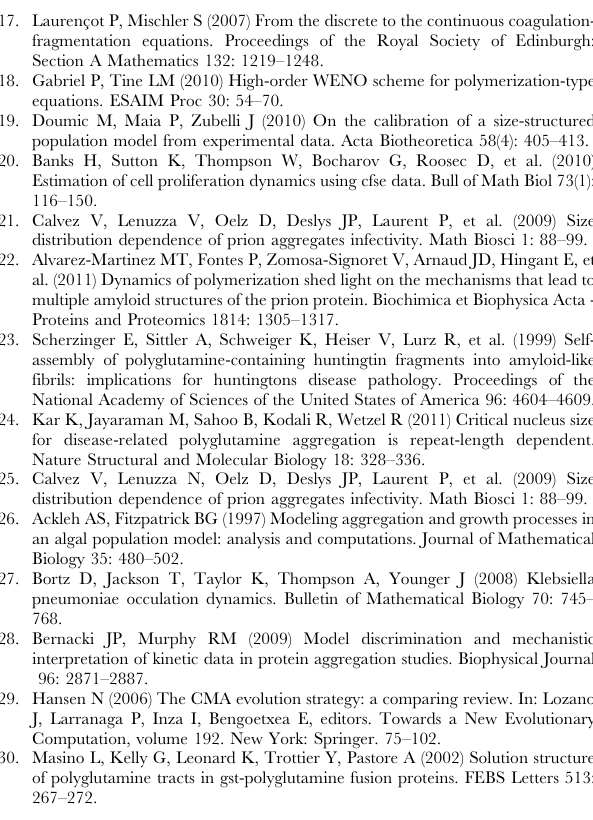
Figure S4 Left: Size distribution of the fragmentation rate for an aggregation of size 20, following a uniform distribution (black) or a Figure S1 Parameter estimation considering each curve mechanical-based distribution (red) of fragmentation. Right: separately. Time evolution of PolyQ41 polymerized mass for an Simulated normalized reaction progress curves of amyloid initial PolyQGST concentration equal to 285 m M . The experimental formation for a uniform distribution (black) and a mechanical- results are plotted in dotted line and the best-fit curve in solide line. i 0 is based distribution (red) of fragmentation. See below for the ~ 0 : 67 h { 1 , k { ~ 0, k N ~ set to 3. Best-fit parameters are k z numerical values. I on I (TIF) Figure S5 Examples of simulated size distribution of the aggregates for a uniform distribution (black) and a mechanical-based distribution (red) of fragmentation. Figure S2 Parameter estimation for Experimental Set 1 See above for the numerical values. when i 0 is set to 3. Time evolution of the adimensioned (TIF) PolyQ41 polymerized mass for an initial PolyQGST concentra- tion equal to 100 m M (A), 285 m M (B), 420 m M (C). Dotted curves Supplementary Data S1 Model derivation from ODE to PDE. represent experimental results. The solid curve is the best-fit. The (PDF) global error in L 2 adimensioned norm was equal to 40% and the optimal parameters are very close to those of Figure 1. Supplementary Data S2 Application to PolyQ41 poly- merization. (PDF) Figure S3 Parameter estimation for Experimental Set 1 when i 0 is set to 1. Time evolution of the adimensioned Supplementary Data S3 Effect of the fragmentation PolyQ41 polymerized mass for an initial PolyQGST concentra- distribution on the kinetics of the Xue et al. model [ 1 ] . tion equal to 100 m M (A), 285 m M (B), 420 m M (C). Dotted curves represent experimental results. The solid curve is the best-fit. The global error in in L 2 adimensioned norm was equal to 11%. The best-fit parameters